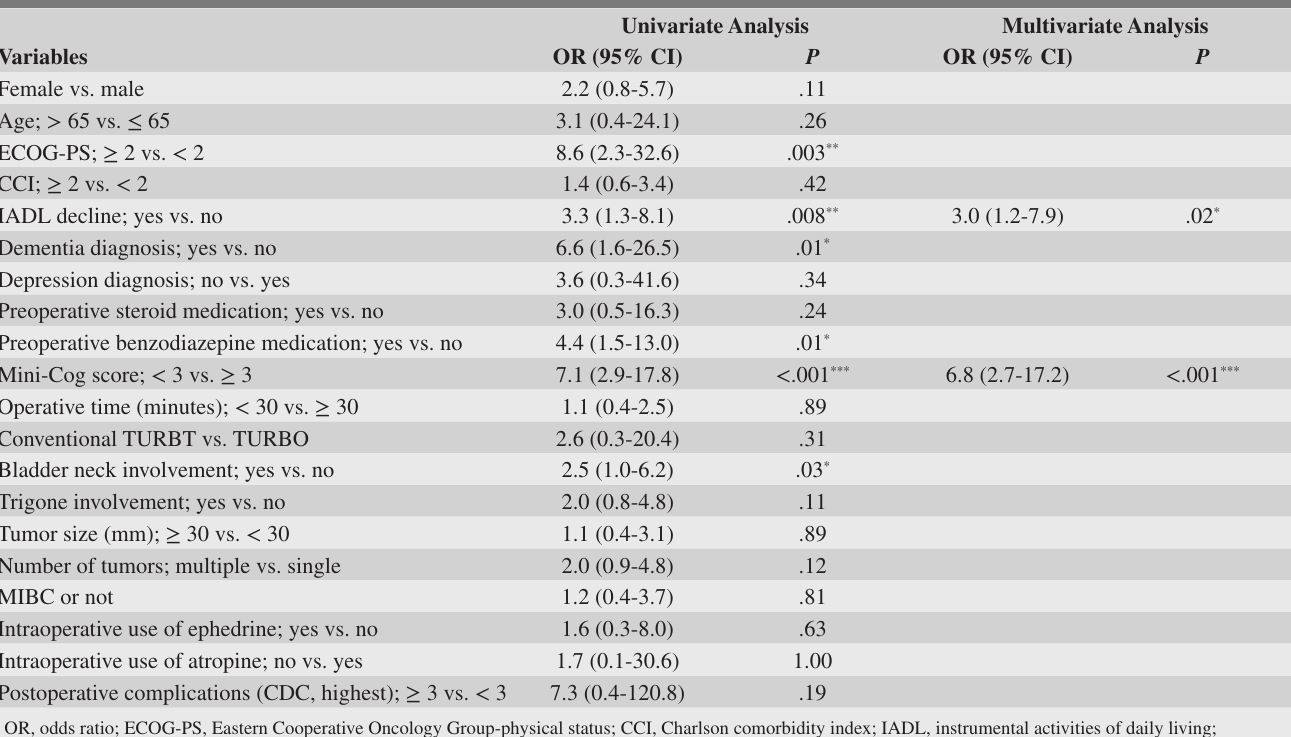
Table 2. Univariate and Multivariate Analysis of Risk Factors for Postoperative Delirium in 193 Patients who Underwent